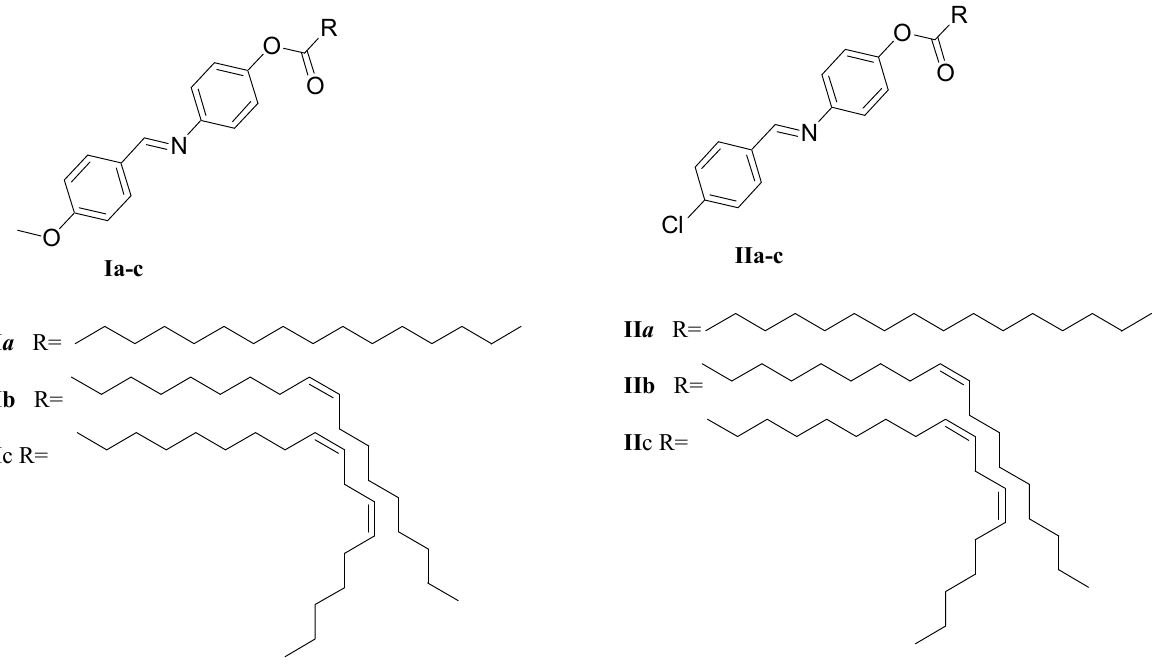
Figure 1. Schematic molecular structural of series Ia-c and IIa-c .